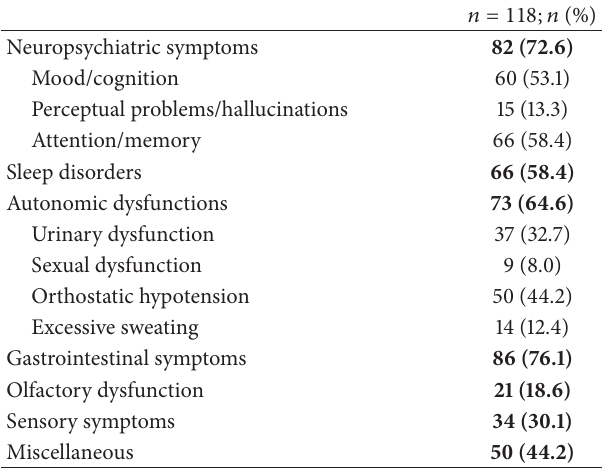
Table 2: Frequency of NMS among the study population.